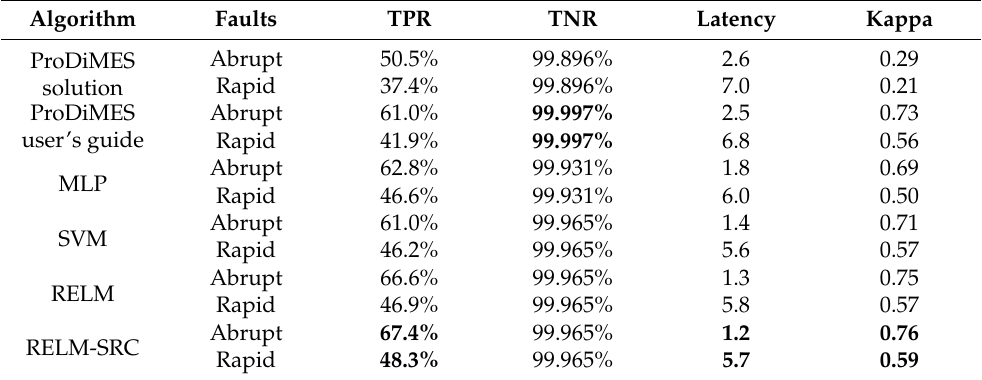
Figure 7. Variation of the number of training healthy engines in RELM-SRC to satisfy TNR ≥ 99.9% (Stage 3). Table 10. Metrics for ProDiMES testing dataset and multi-point analysis averaged for abrupt and rapid faults (Stage 3, comparison with